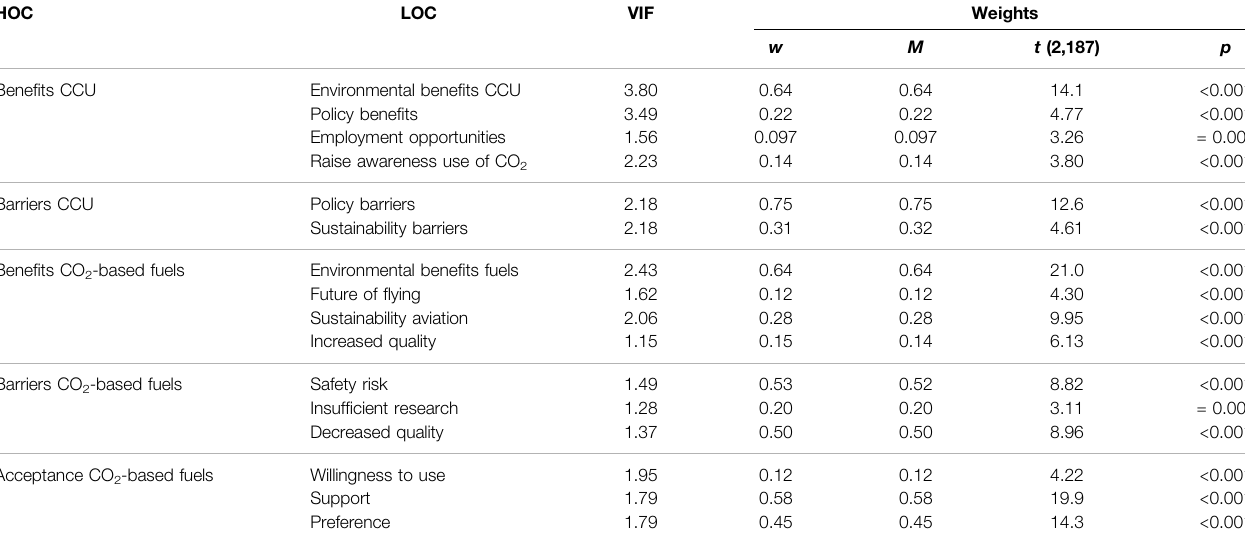
TABLE 5 | Evaluation of the formative higher-order constructs (HOC) based on its lower-order constructs (LOC): collinearity (VIF) and indicator weight (original estimate w , bootstrap mean M , t-statistic t (2,187), p -value). HOC LOC VIF